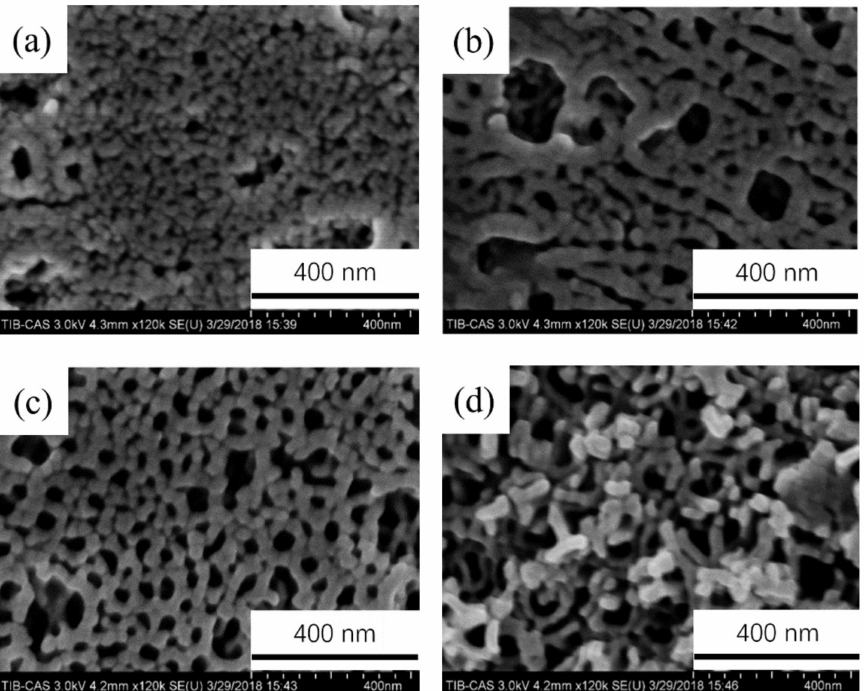
Figure 4. SEM images of 7075 anodic oxide films at different anodic oxidation times: ( a ) 10 min; ( b ) 20 min; ( c ) 30 min; ( d ) 100 min.